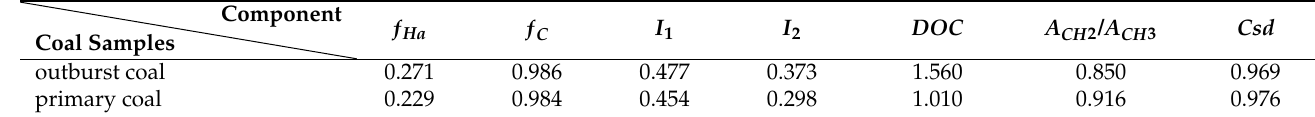
Table 3. Structure parameters summary